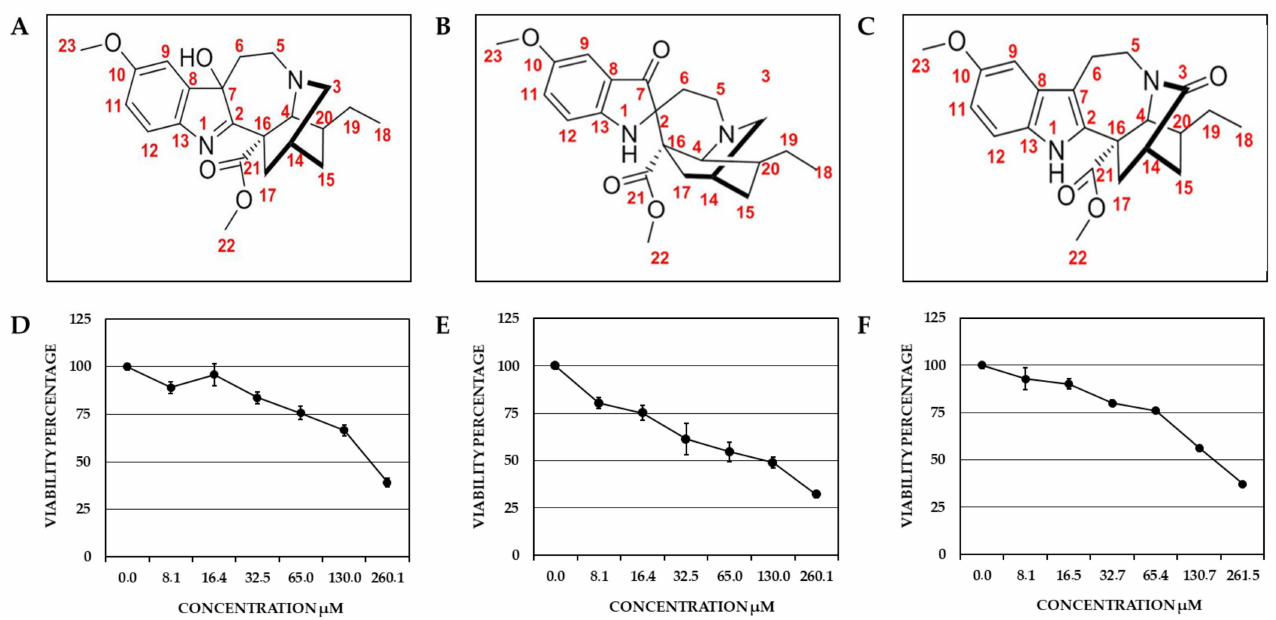
Figure 1. Chemical characterization and cytotoxicity of isolated compounds from T. cymosa. Three compounds were identified, and all were structurally related with VOAC [17]; VOAC-OH ( A ); Rupicoline, also called voacangine pseudo- indoxyl ( B ); and OXO-VOAC ( C ). The viability of these compounds was determined by the MTT method at 2:1 serial dilution ( n : 6). For VOAC-OH, concentrations from 8.1 to 260.1 µ M ( D ); Rupicoline, from 8.1 to 260.1 µ M ( E ) and OXO-VOAC, from 8.1 to 261.5 µ M ( F ) were